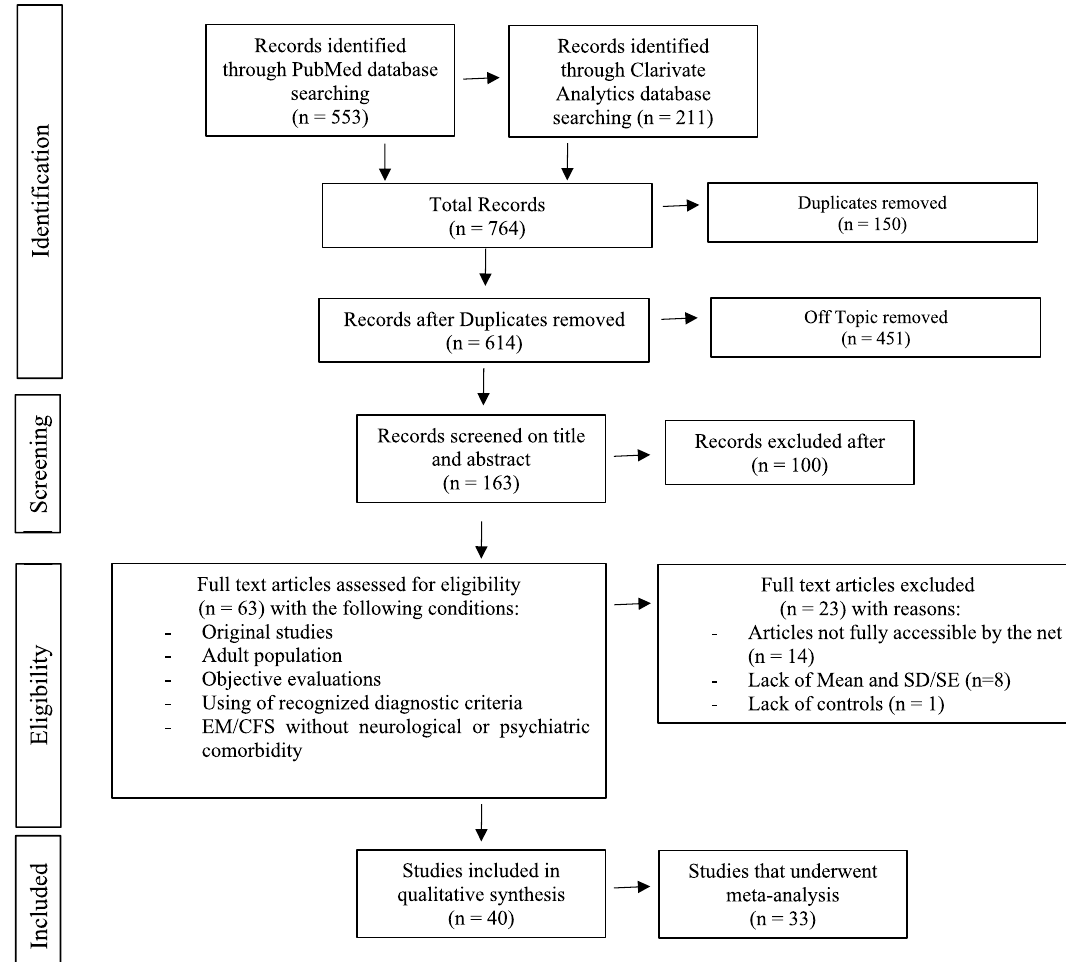
Figure 1. Flow chart depicting the study selection process through the phases of the systematic review and